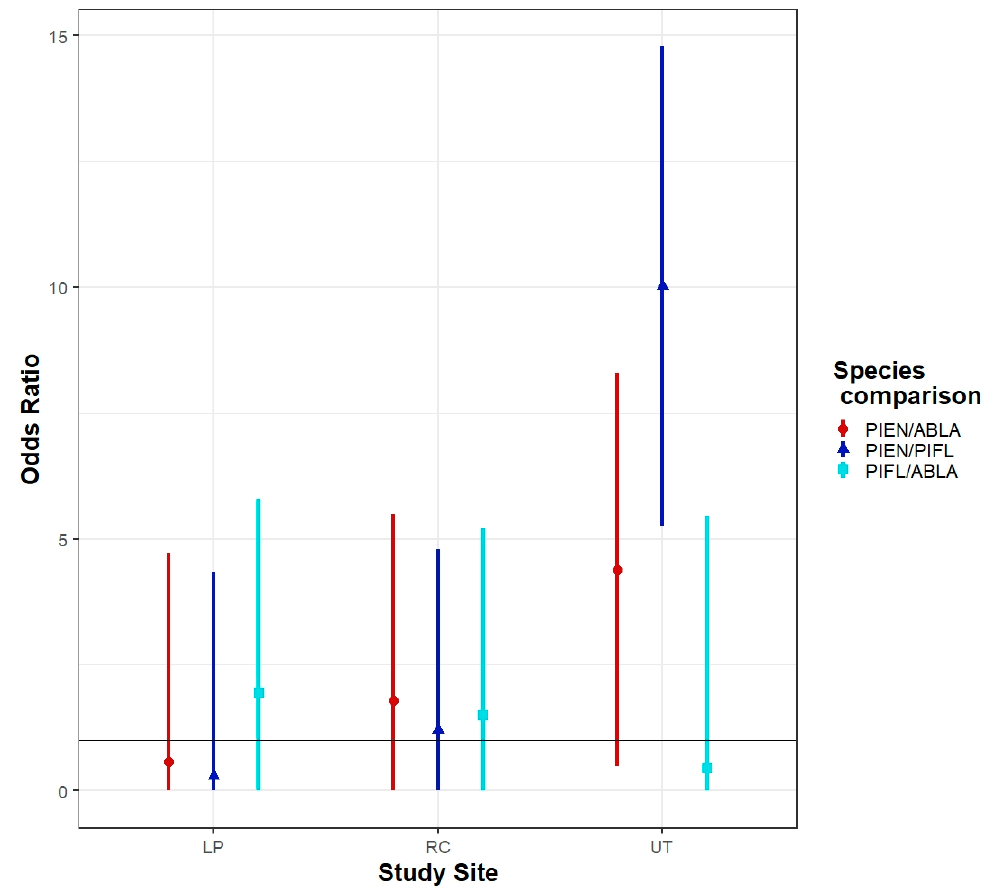
Figure 8. Odds ratios are shown comparing the odds of finding Engelmann spruce (PIEN), subalpine fir (ABLA), or limber pine (PIFL) in the most windward position of multi-tree islands. Results are shown for the Longs Peak (LP), Rainbow Curve (RC), and Ute Trail (UT) study sites. Odds ratios could not be calculated for the Battle Mountain (BM) study site because all six multi-tree islands at this site featured limber pine in the most windward position.